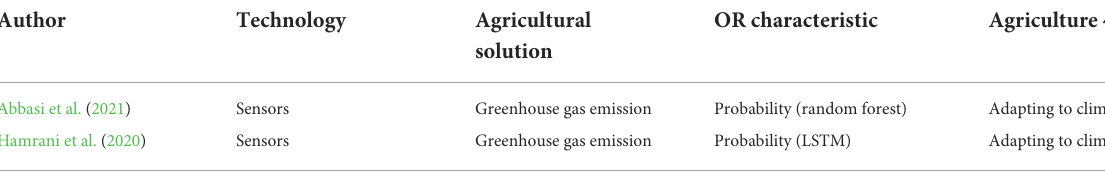
TABLE 11 Research stream: sustainable agriculture using ML techniques.